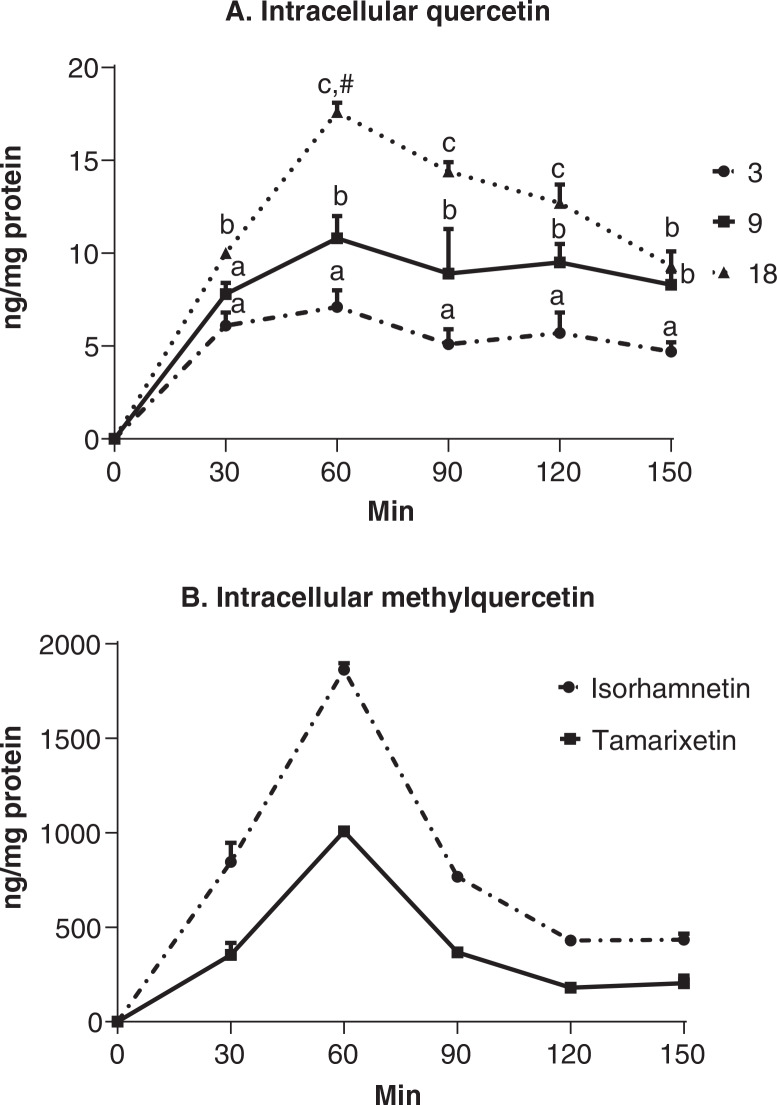
Intracellular quercetin, isorhamnetin, and tamarixetin in Caco-2 cells treated with quercitrin at the concentration of 3, 9, or 18 μg/mL. Vehicle containing no quercitrin was also administered but the data were shown in the figure because isorhamnetin and tamarixetin were not detected. The experiment is conducted in the cells that are cultured for 24 h after being seeded. Flavonoids are quantified using LC-MS in cell lysates at 30, 60, 90, 120, and 150 min post administration. Quercetin is detected in the cells treated using all three doses and isorhamnetin and tamarixetin are only detected at the high dose. Values are expressed as mean ± SD (n = 3).abcMeans at the same time points without sharing the same letter significantly differ (P < 0.05), tested by variance analysis of factorial design, followed by Fisher’s least significant difference (LSD) test with Bonferroni adjustment for multi-comparison. #Mean within the same dose group is significantly different from others at different time points (P < 0.05).